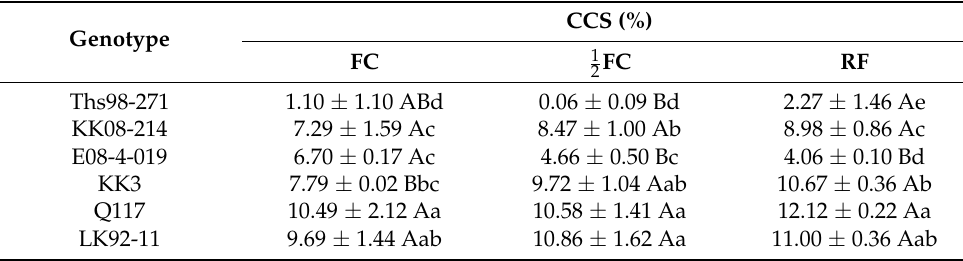
Table 14. Commercial cane sugar (CCS) of six sugarcane genotypes grown under well-watered (FC) and water-stressed ( 1 FC and RF) conditions. 2